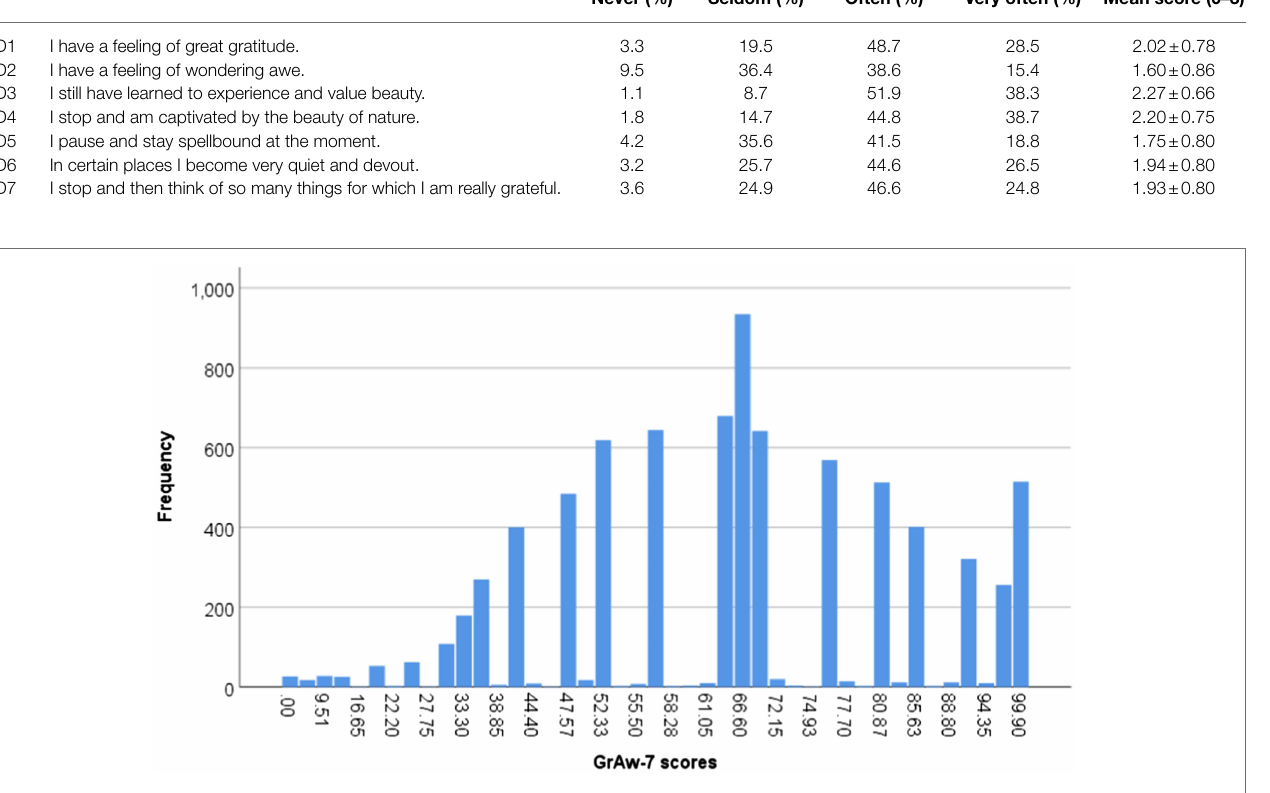
FIGURE 1 | Range of GrAw-7 scores in the